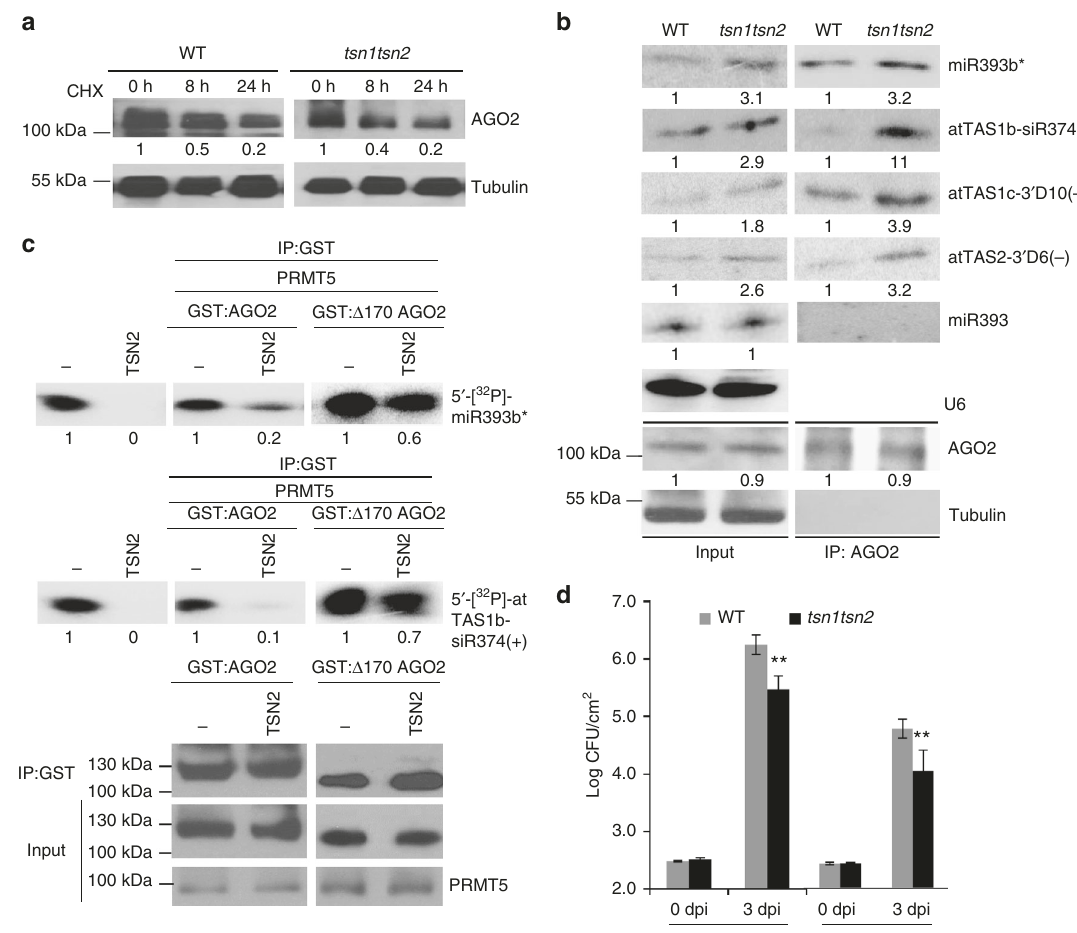
Fig. 5 TSN mediates sRNA degradation, which can be inhibited by deletion of the GAR domain of AGO2. a TSN proteins do not affect AGO2 degradation. The double-knockout mutant tsn1/tsn2 shows that AGO2 degradation is comparable with the WT control. b Although AGO2 levels are unchanged in tsn1/ tsn2 mutants, sRNA levels are higher in AGO2 complexes. U6 RNA was used to show equal loading. c TSN2 degrades AGO2-associated sRNAs. Phosphor images of 5 ′ -[ 32 P] miR393b* and 5 ′ -[ 32 P]-atTAS1b-siR374( + ) after incubation with TSN2 and GST – AGO2 result in degradation of 5 ′ -[ 32 P] miR393b* and 5 ′ -[ 32 P]-atTAS1b-siR374( + ). Degradation of sRNAs is largely inhibited after GAR domain deletion, as shown in the incubation of TSN2 and sRNAs with GST: Δ 170 AGO2. d The tsn1tsn2 double- mutant plants are more resistant to bacterial infection. Error bars represent standard deviation. Asterisks indicate mean values that differ signi fi cantly from wild-type (** P -valve < 0.01). Tubulin levels were used to show equal loading for all Western blots. In all panels, signal intensity was calculated using